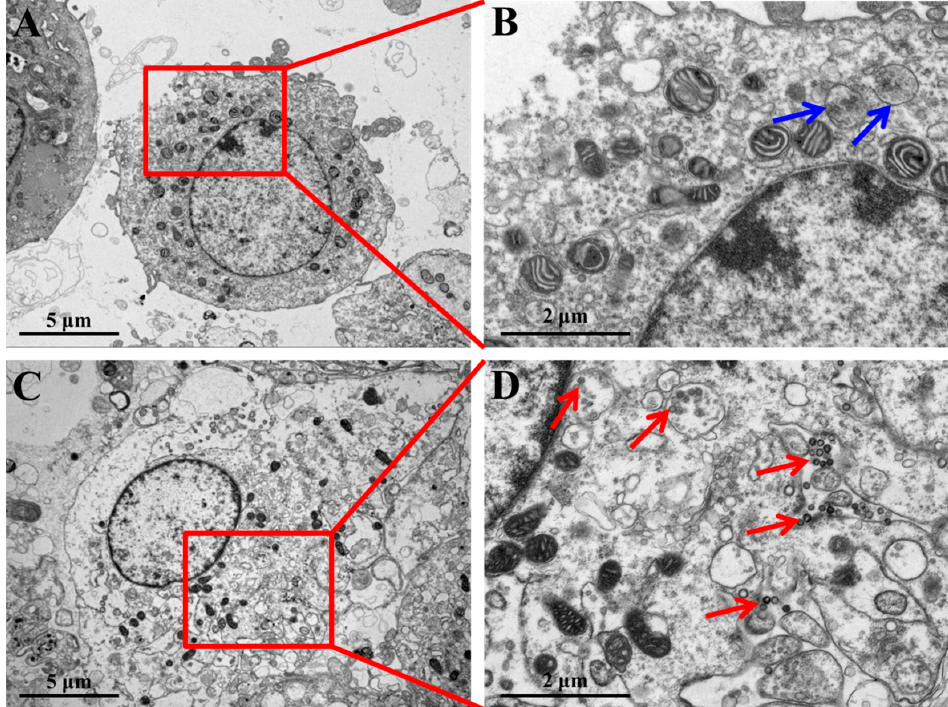
area in G . The red arrow represents the spermatogenic cells of the seminiferous tubules; the blue asterisk represents Leydig cells. Scale bars, 200 µm ( A , E ), 100 µm ( B , F ), 50 µm ( C , G ), and 20 µm ( D , H ).